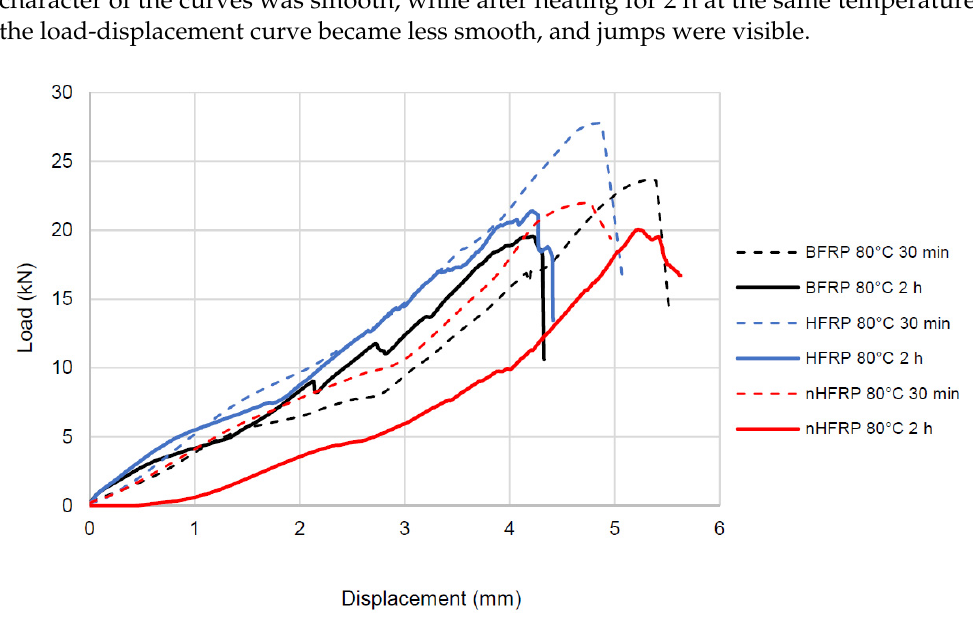
Table 3. The aaverage failure time and average shear stress in relation with bar heated time; (1)—bars heated at 80 °C for 30 min, (2)—bars heated at 80 °C for 2 h. Type of Bar Average Failure Average Shear Time (s) Stress (MPa)